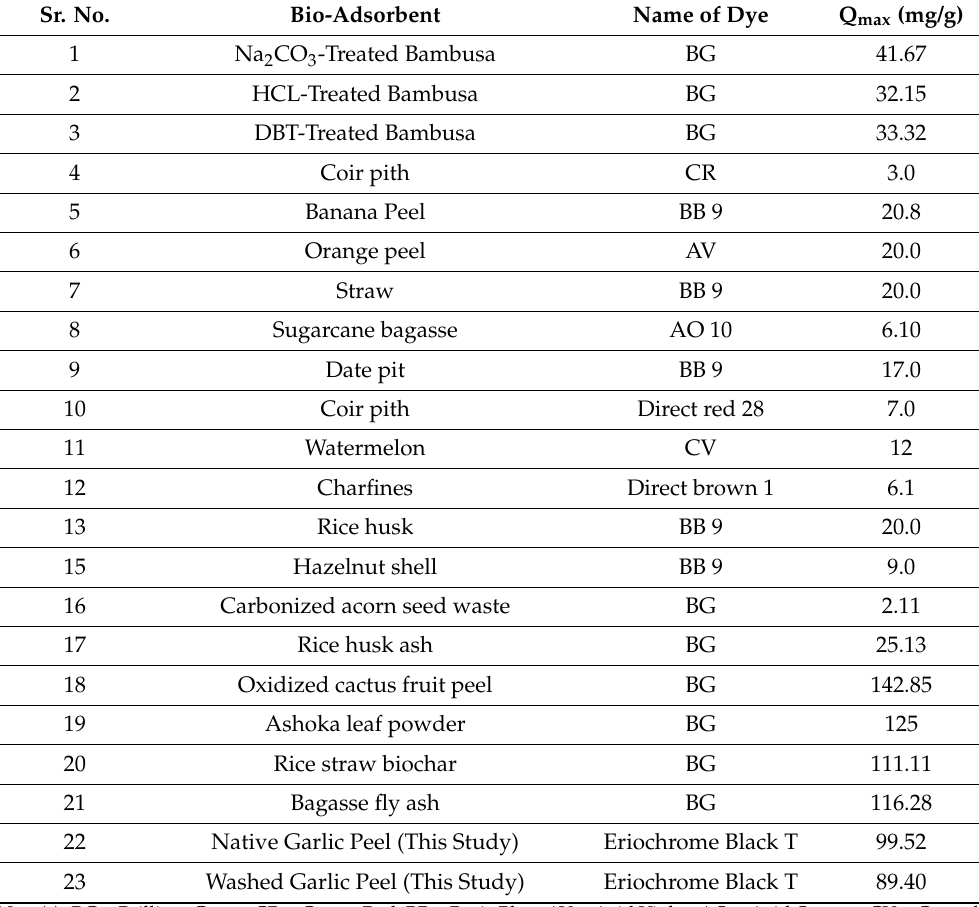
Table 5. Comparison of different bio-adsorbents utilized for the decontamination of different dyes from aqueous environment [22,23].